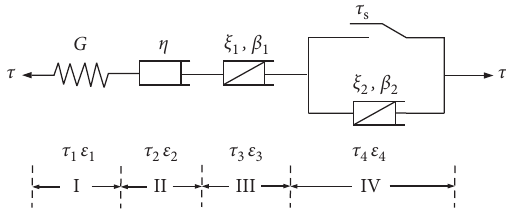
Figure 1: Diagram of the Scott-Blair element components.